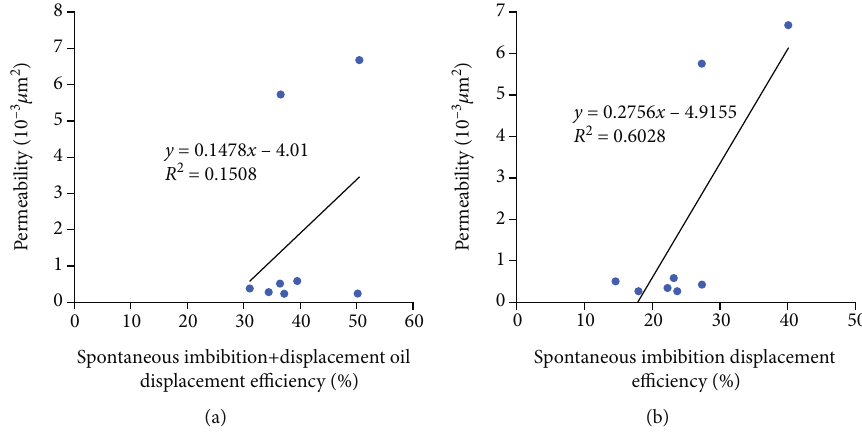
Figure 6: Correlation between oil displacement e ffi ciency and